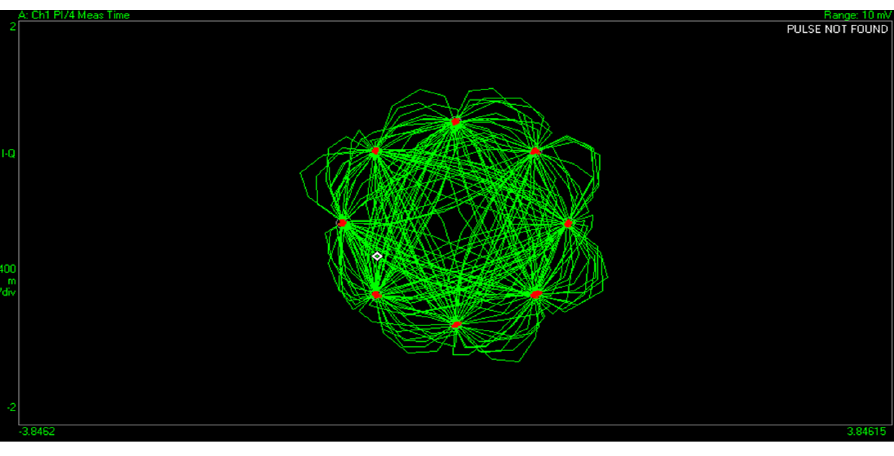
Figure 14. The constellation corresponding to π over 4 DQPSK modulation.